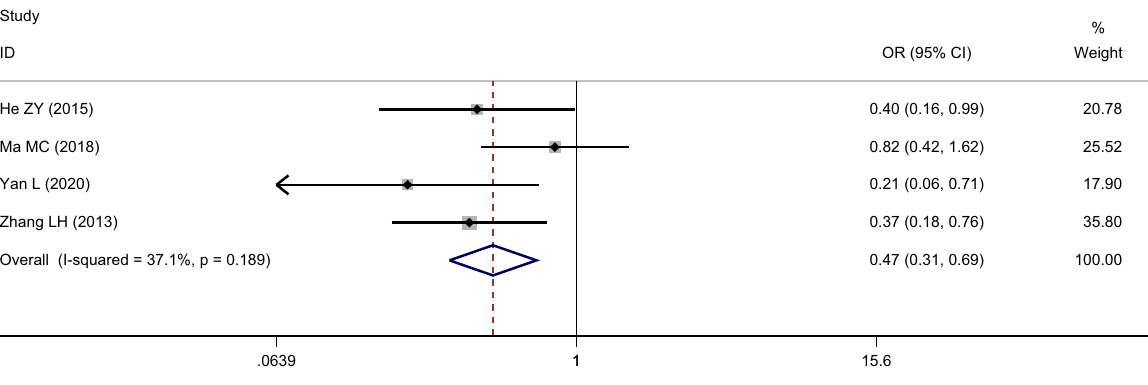
Figure 6: Forest fi gure of relationship between the expression of SIRT1 and lymph node metastasis of